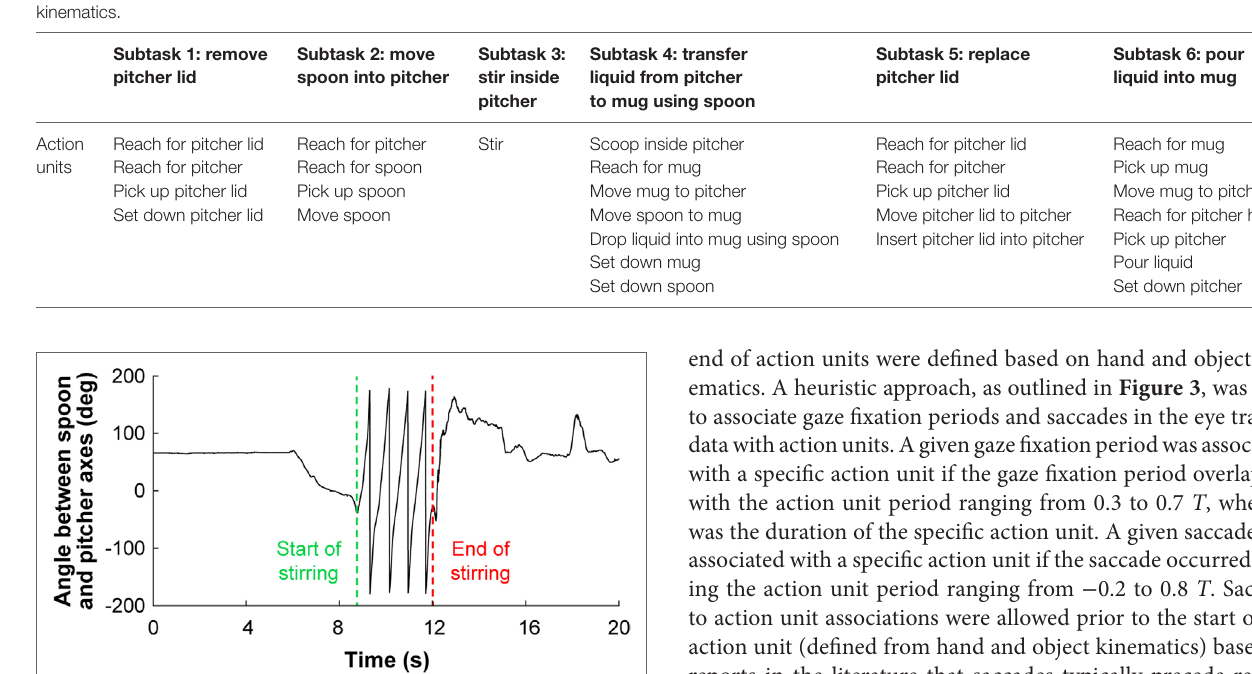
FigUre 2 | The repetitive nature of the spoon’s kinematics with respect to the pitcher was used to identify the start and end of the action unit “stir inside pitcher.” Although the spoon was not manipulated until approximately 6 s had elapsed in the representative trial shown, the full trial is provided for completeness.